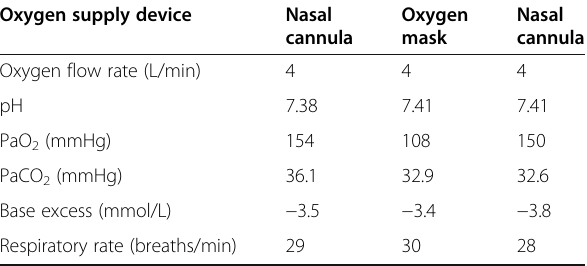
Table 1 Results of blood gas analysis in the COVID-19 patient Oxygen supply device Nasal